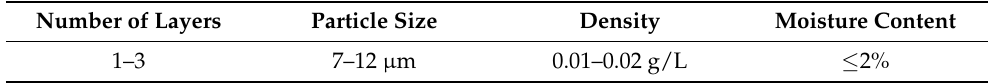
Table 1. The details of the graphene.